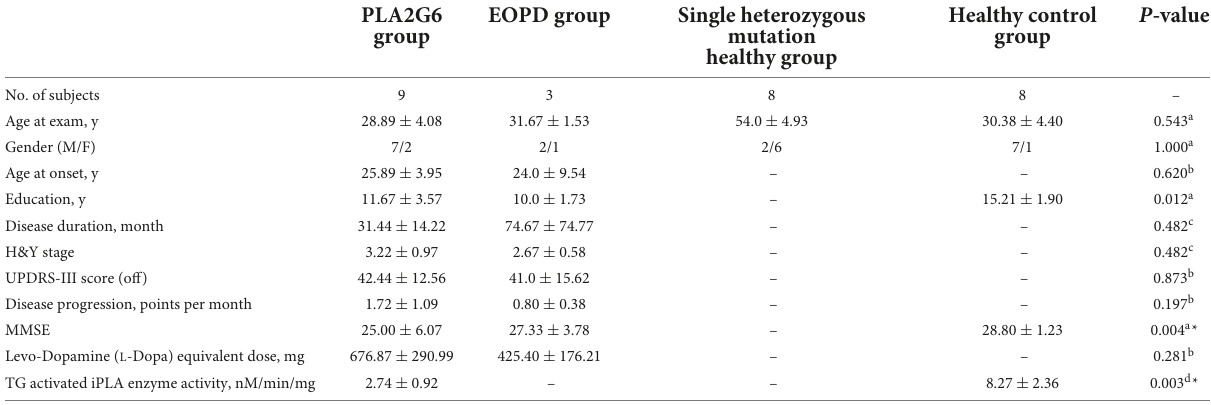
TABLE 2 Demographic and clinical characterization of study